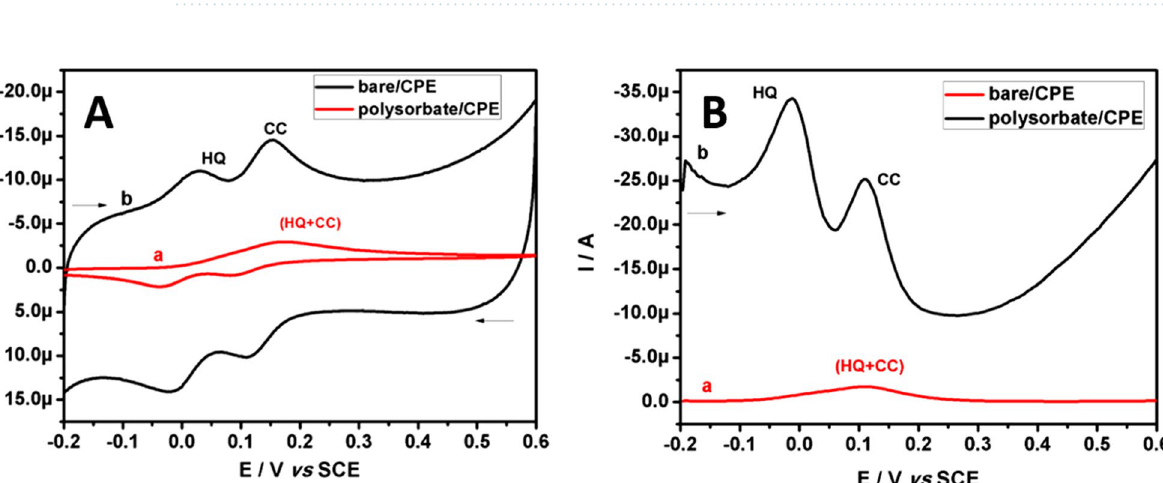
Table 4. Comparison of LOD obtained for CC and HQ at polysorbate/CPE with other modified electrodes, method and pH of the supporting electrolyte used.